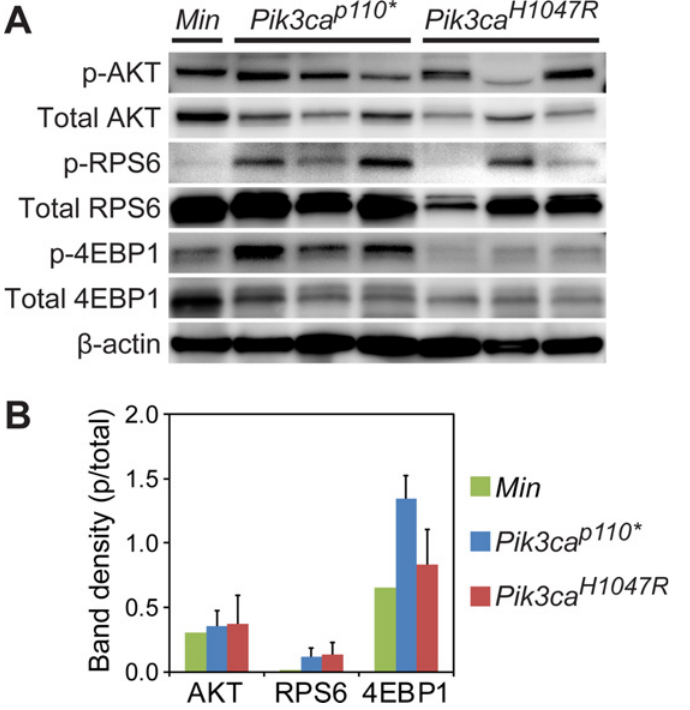
Fig 3. The PI3K pathway is activated in Apc Min/+ , Fc + Pik3c a p110 * , and Fc + Pik3ca H1047R mice. Immunoblotting demonstrates robust phosphorylation of AKT in Apc Min , Fc + Pik3c a p110 * and Fc + Pik3ca H1047R colon tumors (A). Increased phosphorylation of RPS6 and 4EBP1 beyond that seen in the Apc Min lesions is observed in the Fc + Pik3ca H1047R and Fc + Pik3c a p110 * colon tumors. The more aggressive phenotype seen in the Fc + Pik3c a p110 * mice, with a greater number and decreased latency, is associated with an increased phosphorylation of 4EBP1 compared to Fc + Pik3ca H1047R tumors (B).